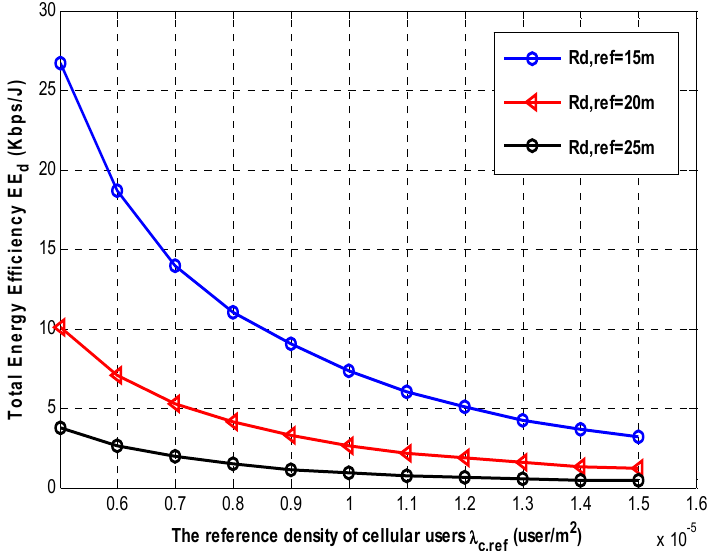
Figure 7. The energy efficiency of D2D users against the reference density of cellular users by using the modified derivative algorithm with different parameters.